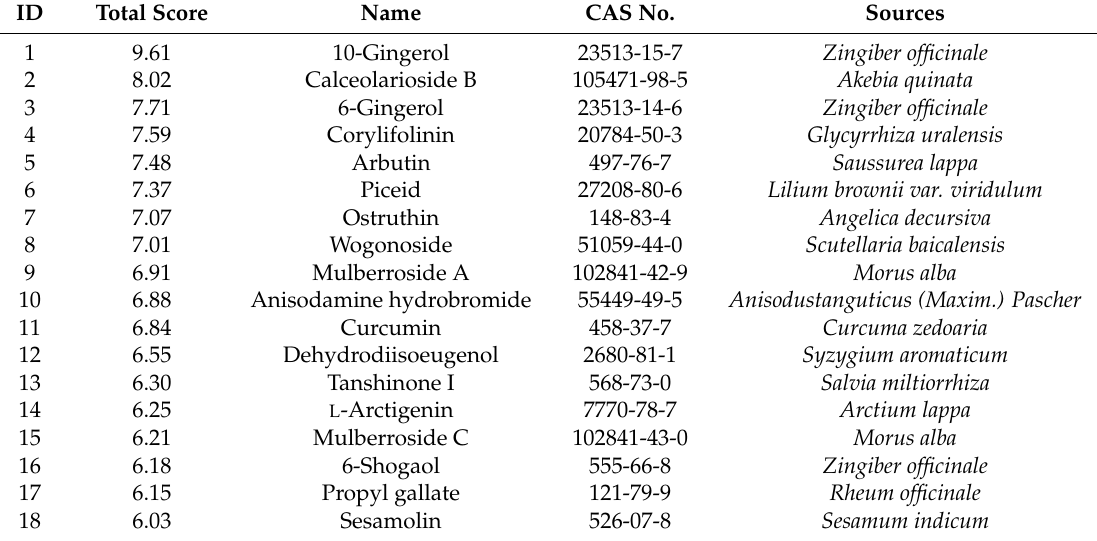
Figure 2. The binding site of theCG9 ligand in the inhibitor binding site of Syk. The red and green compounds represent the co-crystal and docked conformations of theCG9 ligand in Surflex-docking, respectively. The red dotted lines indicate hydrogen bond interactions between CG9 and Syk. Table 1. The hits from docking-based virtual screening.